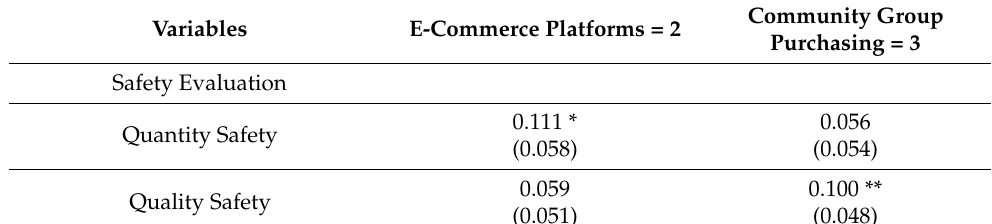
Table 3. MProbit model regression results (with supermarket as the benchmark